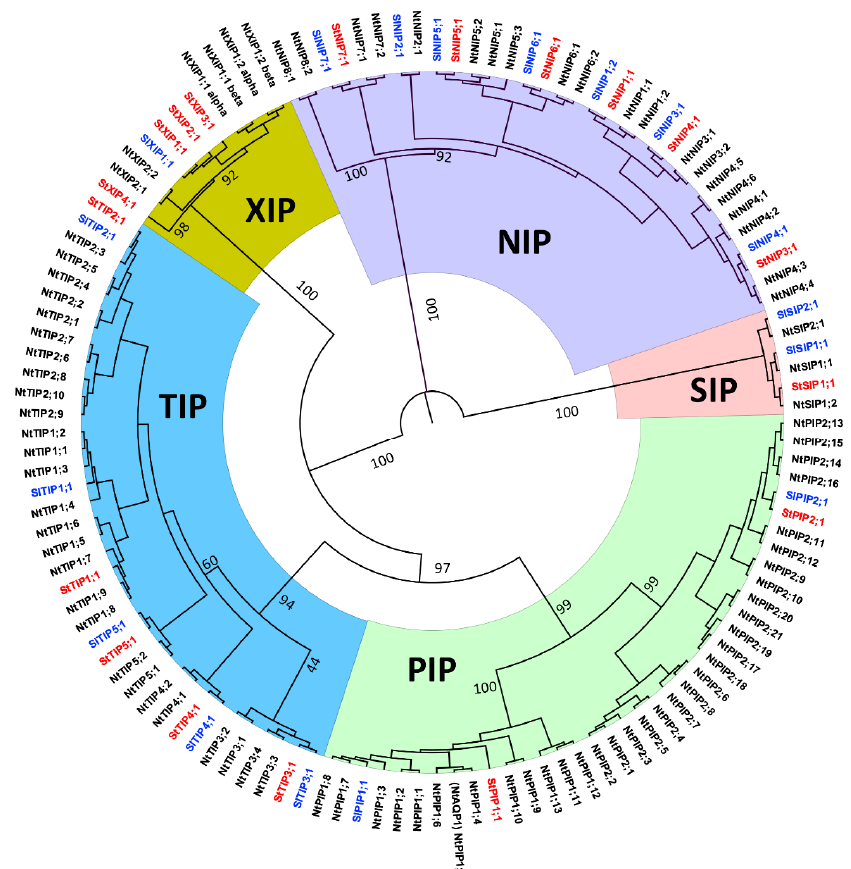
Figure 1. Phylogenetic relationships among Nicotiana tabacum , Solanum tuberosum , and Solanum lycopersium AQPs. For this analysis, 35 selected subgroup representative StAQPs and SlAQPs were aligned with all NtAQPs using the Clustal Omega server (http: // www.ebi.ac.uk / Tools / msa / ClustalOmega / ) and a phylogenetic tree was constructed using Maximum Likelihood method based on the JTT matrix-based model with 1000 bootstraps. AQPs clustered into five di ff erent subfamilies (PIPs, TIPs, NIPs, SIPs, and XIPs). Each AQP subfamily is shown with a specific background color. NtAQPs are indicated in black; StAQPs and SlAQPs are in red and blue,